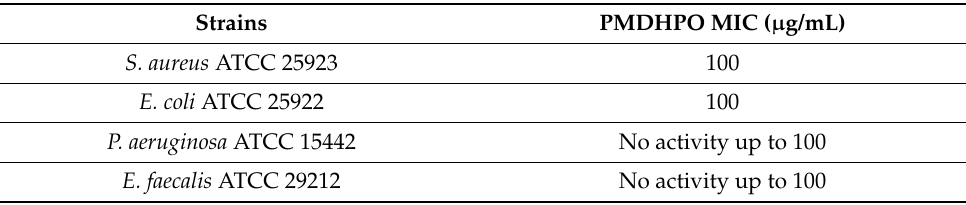
Table 1. Antibacterial activity reported in terms of MIC against bacterial strains grown as planktonic cell cultivation on